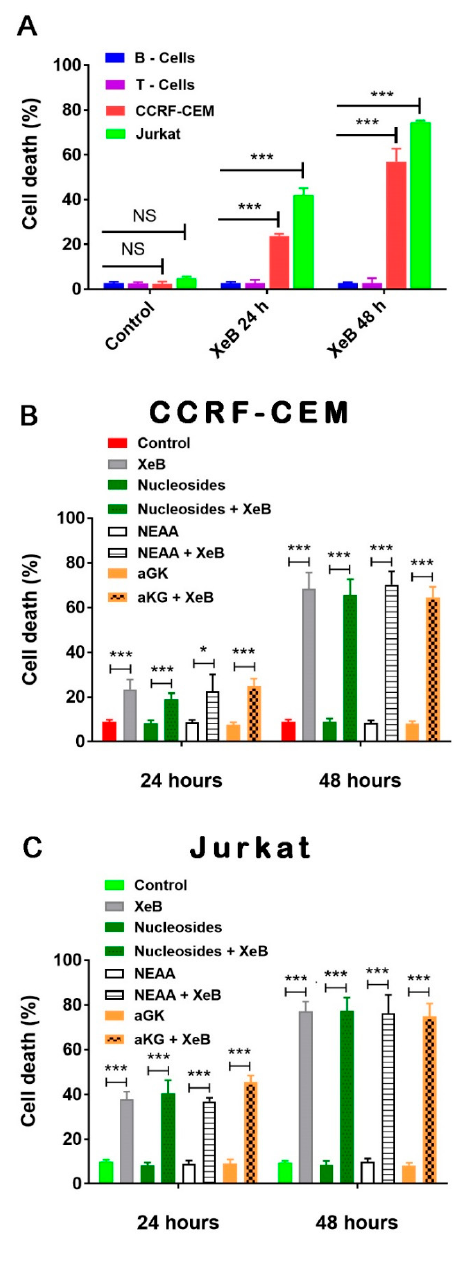
Figure 7. InsP3R inhibition induces cell death in T-ALL cells, which cannot be reverted by intermediate metabolites. ( A ) T-cells (purple), B-cells (blue), CCRF-CEM (red), and Jurkat (green) cells were treated with 5 µM XeB for 24 h and 48 h, and cell death was determined by propidium incorporation using flow cytometry. ( B ) CCRF-CEM cells were treated with 5 µM XeB for 24 and 48 h in the presence of either nucleosides, 5 mM α -ketoglutarate, or non-essential amino acids (NEAA) and cell death was determined by propidium incorporation using flow cytometry. ( C ) Jurkat cells were treated with 5 µM XeB for 24 and 48 h in the presence of either nucleosides, α -ketoglutarate, or NEAA, and cell death was determined by propidium incorporation by means of flow cytometry n = 3, mean ± S.E., * p < 0.05, *** p < 0.001 ( t -test).